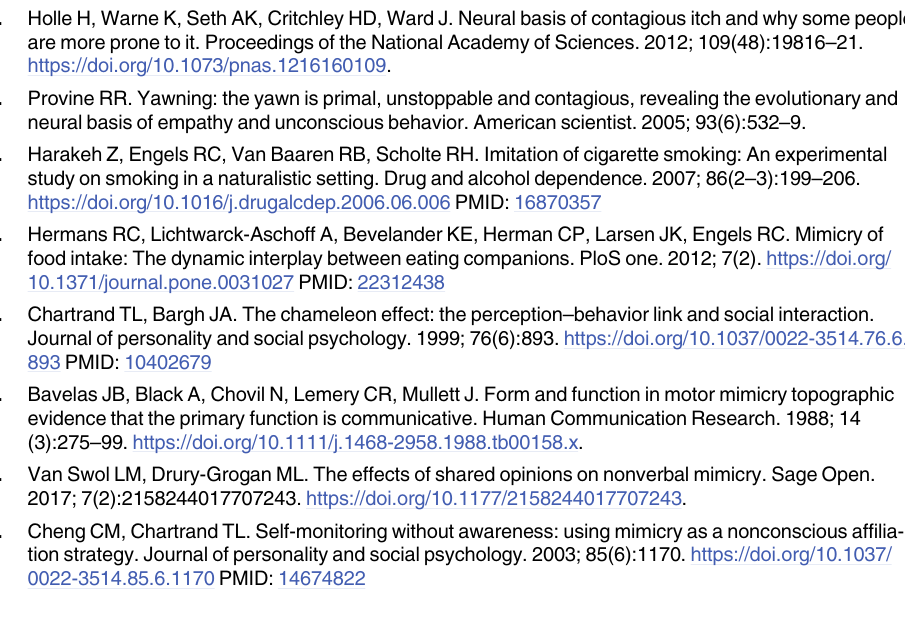
S12 Table. Results of mixed model analysis of fidget data.